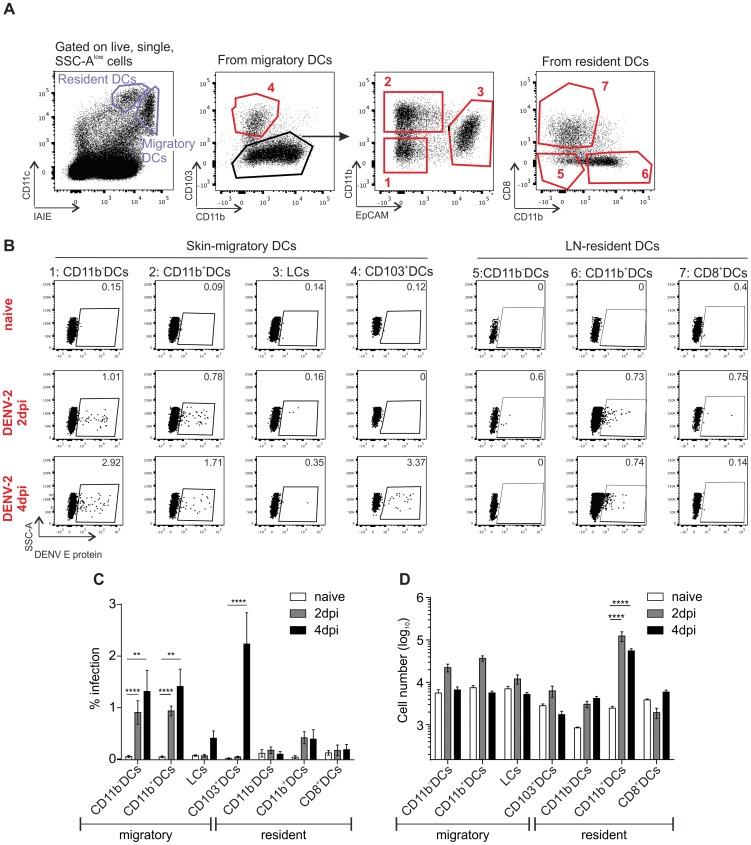

In vivo infection of resident and migratory DCs in the skin-draining lymph node of IFNAR−/− mice and their migratory behavior.(A) Gating strategy to identify lymph node (LN)-resident and migratory DCs in the skin-draining LN of IFNAR−/− mice. Resident DC subsets are either CD8+ (1), CD11b− (2) or CD11b+ (3), while migratory DC subsets incorporate those found in the skin: CD103+ (4), CD11b− (5), CD11b+ (6) and Langerhans Cells (LCs, 7). (B) Mice were inoculated i.d. with 1×106 pfu of DENV-2 D2Y98P/ear and skin-draining lymph nodes (LN) were harvested 2 and 4 days post infection (dpi). Presence of DENV E protein was established by flow cytometry in both LN-resident and migratory DC subsets. (C) Summary of data from (B), 4 to 5 mice (average of two LN/mouse) per group pooled from two independent experiments, mean ± SEM, analyzed with one-way ANOVA followed by Tukey's multiple comparison test, *p<0.05; **p<0.01; ***p<0.001; ****p<0.0001; non-significant differences are not indicated. (D) Quantification of DCs isolated from LNs at 2 and 4 dpi to address infiltration and migration of different cell subsets. Same conditions as in (C).